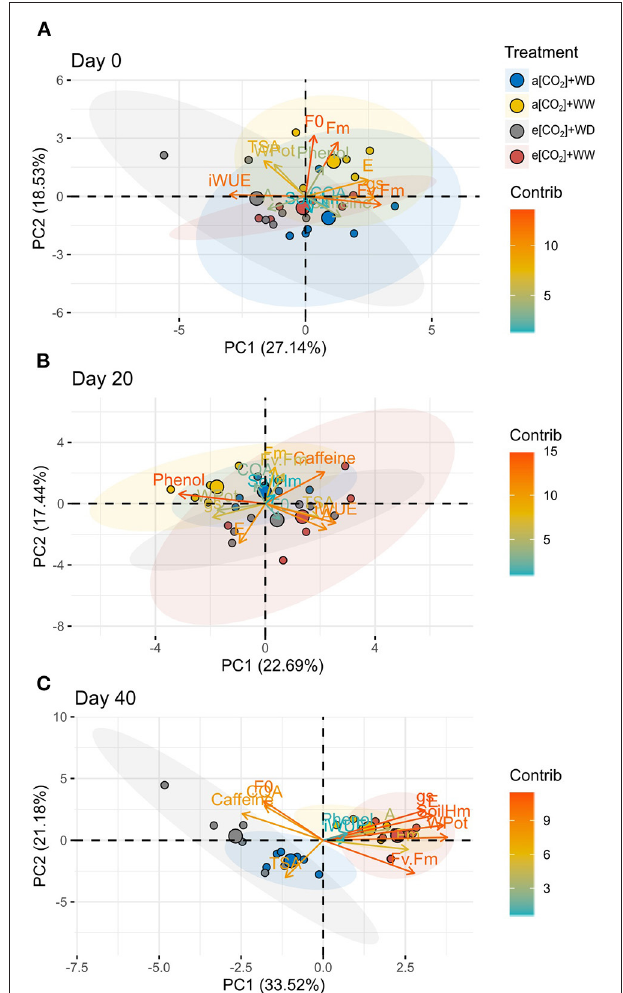
FIGURE 7 | Principal component analysis of physiological and biochemical variables and treatments of C. arabica plants exposed to ambient [CO 2 ] under well-watered and water deficit (a[CO 2 ] + WW and a[CO 2 ] + WD, respectively) and elevated [CO 2 ] under well-watered and water deficit (e[CO 2 ] + WW and e[CO 2 ] + WD, respectively) conditions on day (A) 0, (B) 20, and (C) 40 after water deficit imposition in the OTC. Numbers in parentheses give the per cent variation explained by the first and second principal component. The color and distribution of each variable depending on their contribution to each principal component. Variables abbreviation: CQA, 5-CQA; Phenol, Total phenolic compounds; WPot, Leaf water potential; Fv.Fm, F v /F m ; SoilHm, Soil